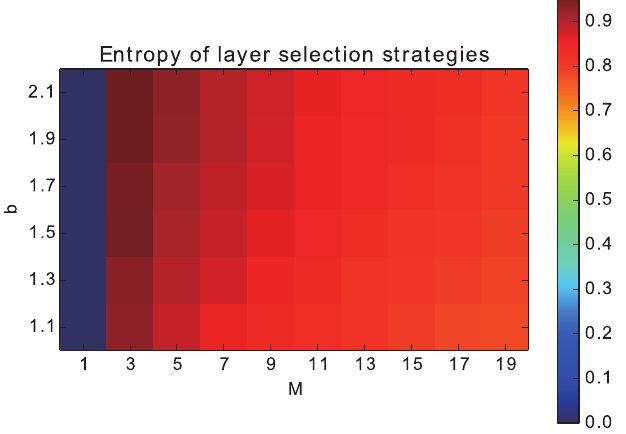
Figure 3. The normalized entropy of the probability distribution of layer selection strategies sl i . The slight decrease in the entropy with increasing M from 2 implies that the uneven distribution of individuals could contribute to the evolution of cooperation.